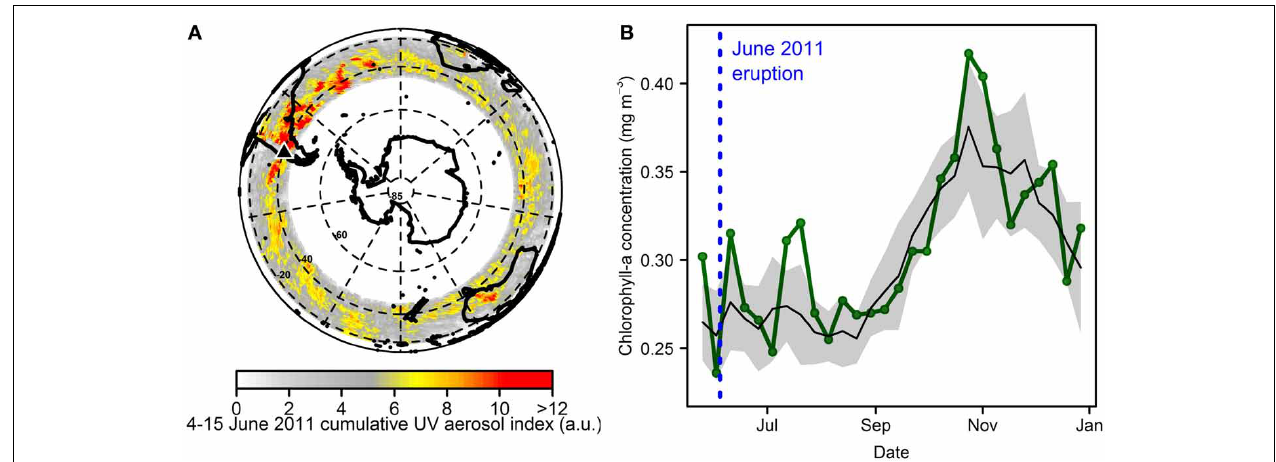
FIGURE 7 | Atmospheric aerosol loading from the Puyehue-Cordón Caulle (PCC) 2011 eruption and limited chlorophyll-a response detected by satellite. (A) Atmospheric aerosol loading for 4–15th June 2011 (UV aerosol index from EOS Aura OMI summed over these dates) showing the